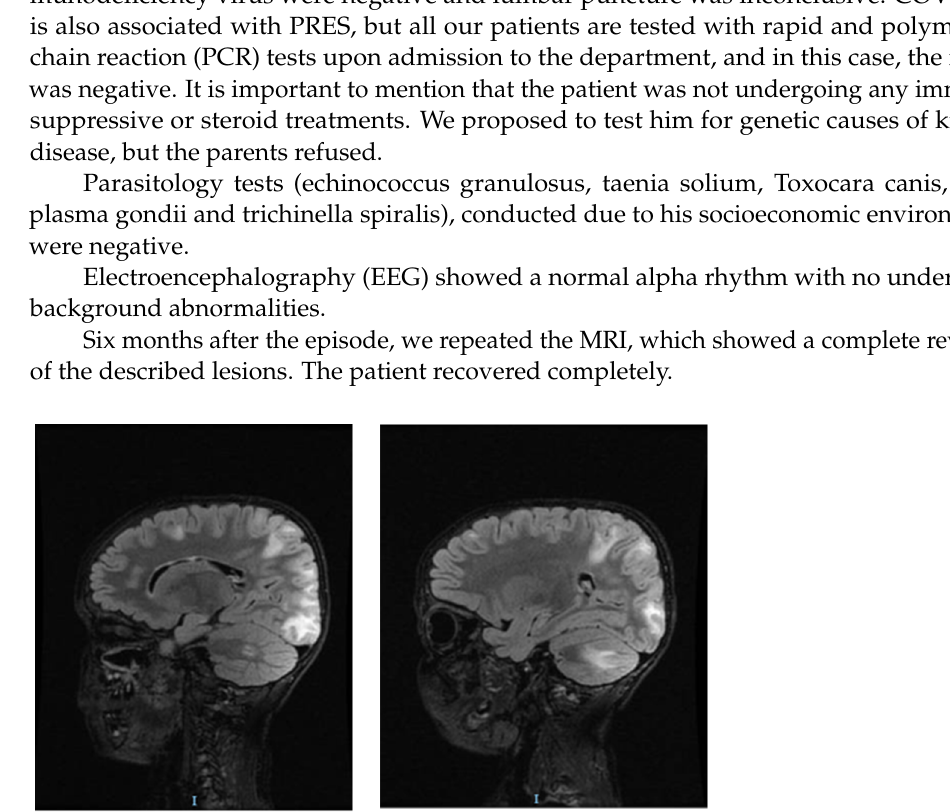
Figure 1. Brain MRI of patient with hyperintensities speci fi c for PRES: T2 FLAIR modi fi cations in the parieto-occipital regions.